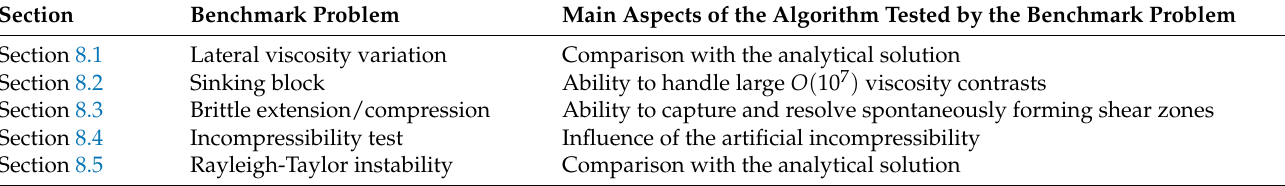
Table 1. Benchmark problems